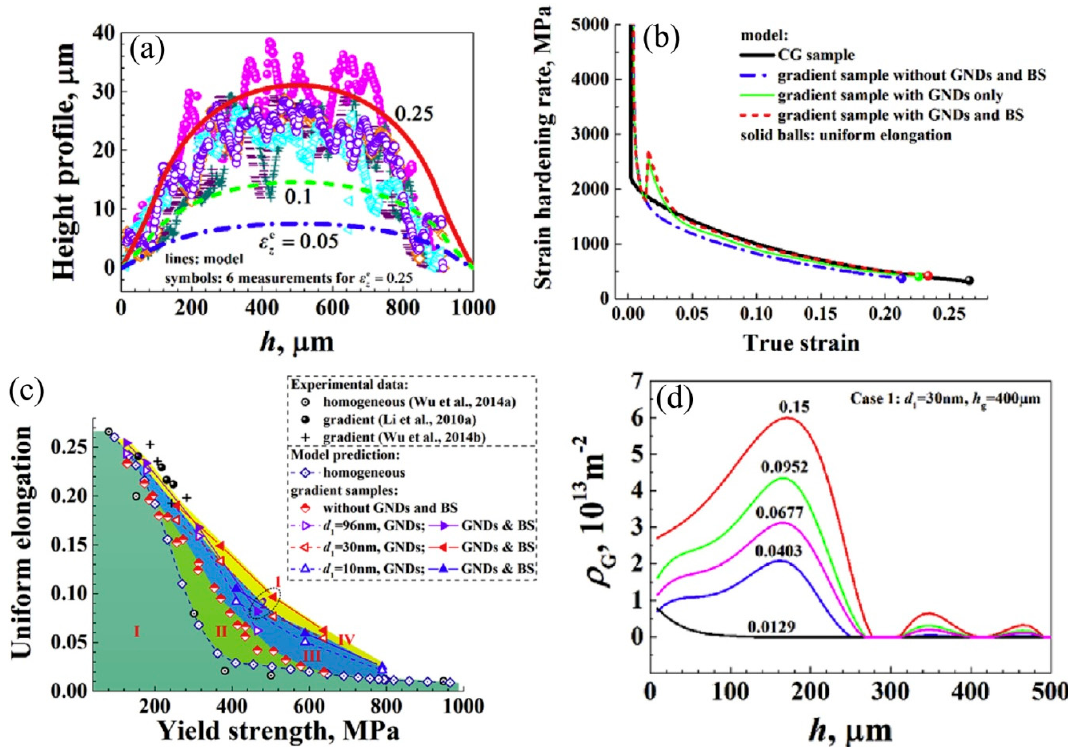
Figure 11. Dislocation density-based continuum plasticity modeling for gradient structure: ( a ) The predicted height profile on the lateral surface of a gradient IF steel and comparison with experimental data; ( b ) The predicted strain hardening rate and comparison with experimental data; ( c ) Strength–ductility maps of the gradient IF steel considering GNDs and back stress; ( d ) The predicted GNDs density distributions for one case. Adapted from [54].